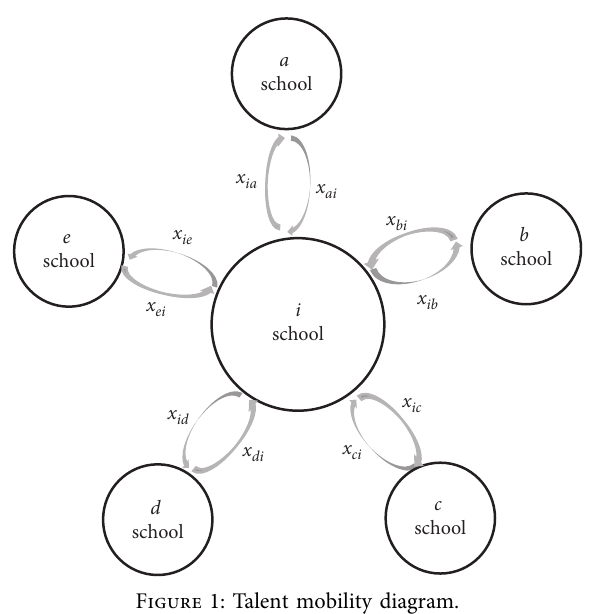
Figure 1: Talent mobility